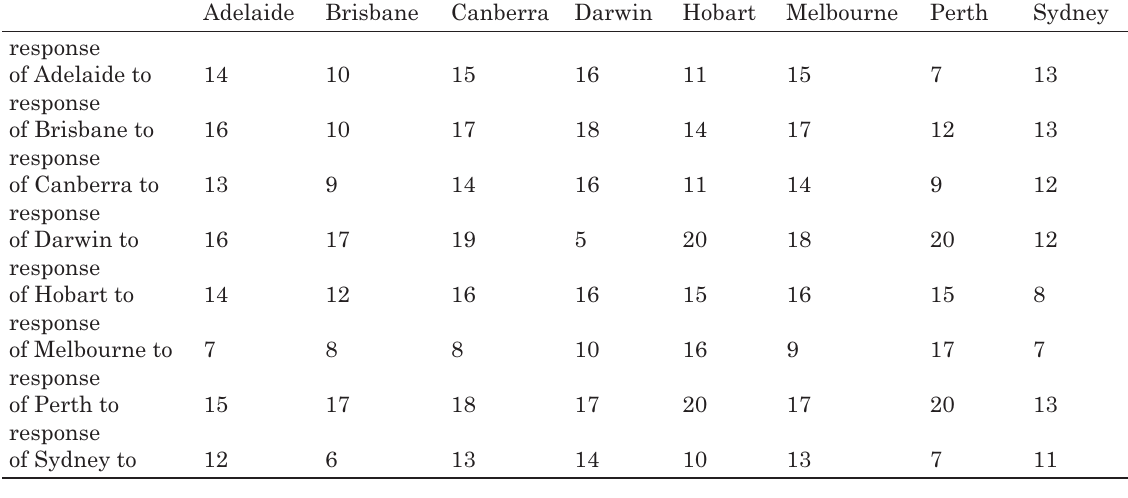
Table 6. Lagged terms when fi rst reaching a value of impulse response of less than 0.01